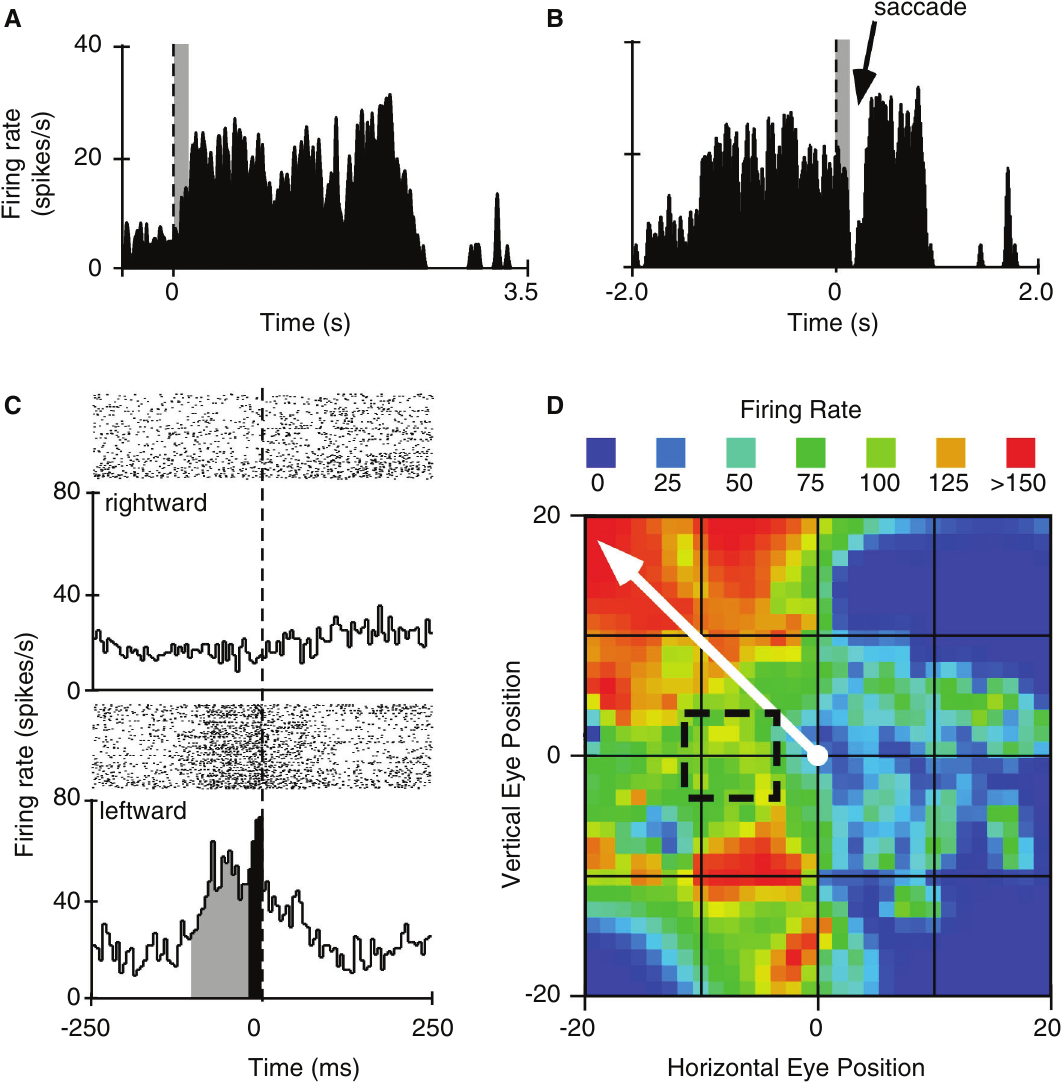
Figure 5. Fixation and saccade-related neural activity in the intermediate superior colliculus . A . Summed histogram from multiple trials triggering visual stimulus-induced activity in a “fixation” neuron located at the rostral pole and superficial layers of the superior colliculus (SC). Electrophysiological responses (timestamps for spikes) were aligned to the time at which the subject acquired the fixation target to begin the trial. B . Saccade-triggered transient suppression of neural activity in a different neuron located within intermediate layers and caudal to the fixation-neuron in the same animal. Dashed vertical line is at time zero for stimulus presentation in “A” and for target fixation in “B”. The width of the grey bar indicates the neuron’s visual delay (>20 ms). C . Raster plots (above) and binned profile of summed response (below) to compare neural activity during rightward (top panel) and leftward (bottom panel) saccades. Grey bins indicate the build-up phase while the black bins indicate the burst phase of the neuron. Dashed vertical line indicates saccade onset. D . Heat map of saccade-related neural activation. Black box enclosed by dashed lines indicates position of the target image relative to central gaze. Solid white arrow represents the vector for the preferred saccade as indicated by firing rate of the